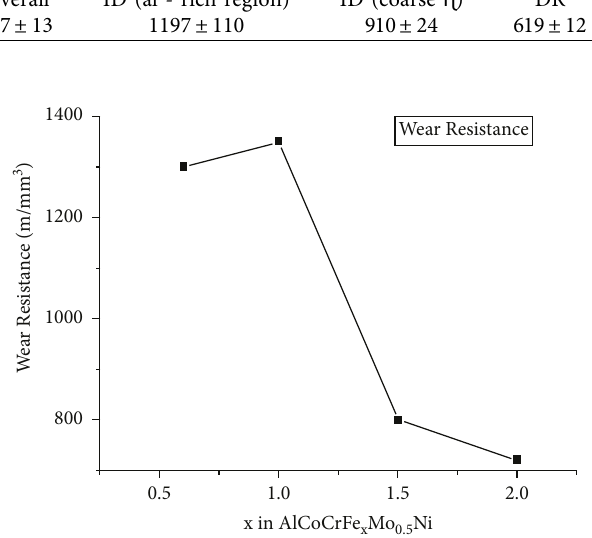
Figure 18: Wear resistance of AlCoCrFexMo respect to Fe content